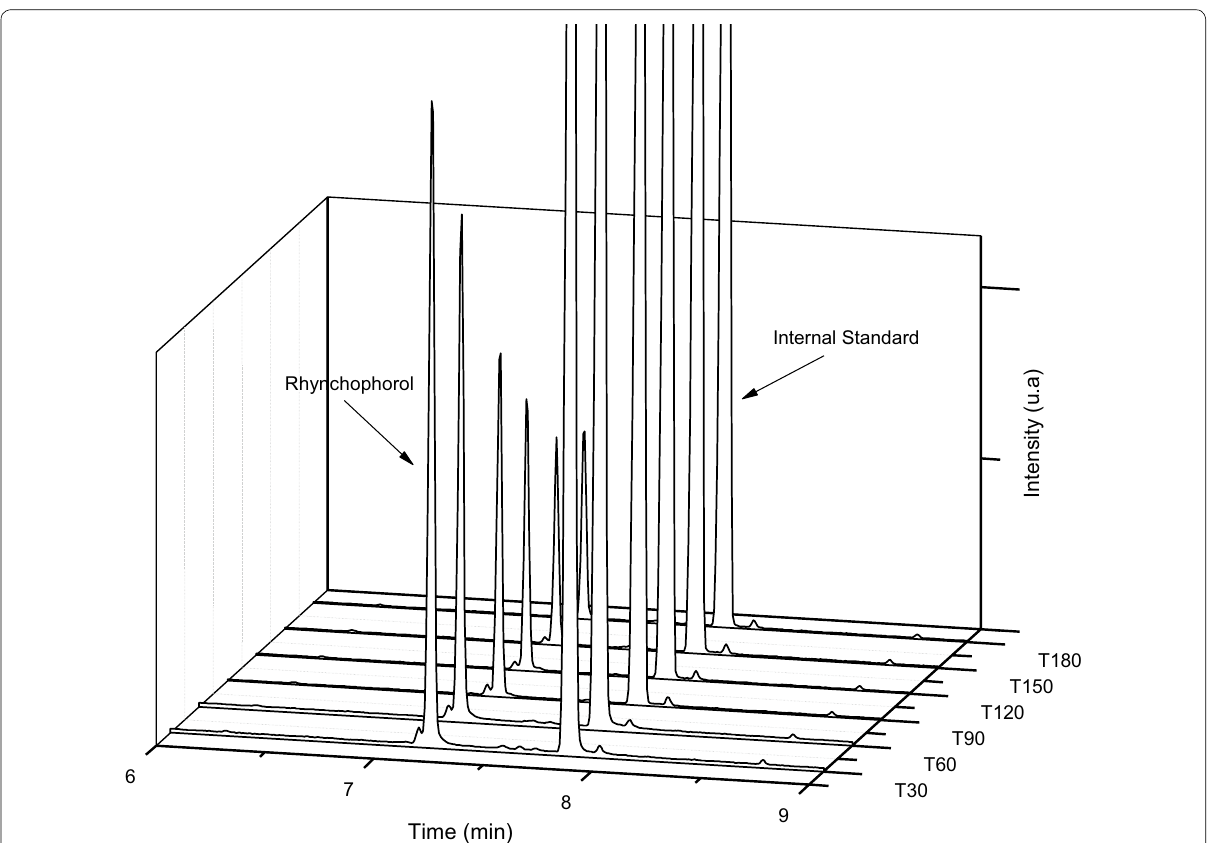
Fig. 6 Storage of Na-magadiite/rhynchophorol composite for intervals of up to 180